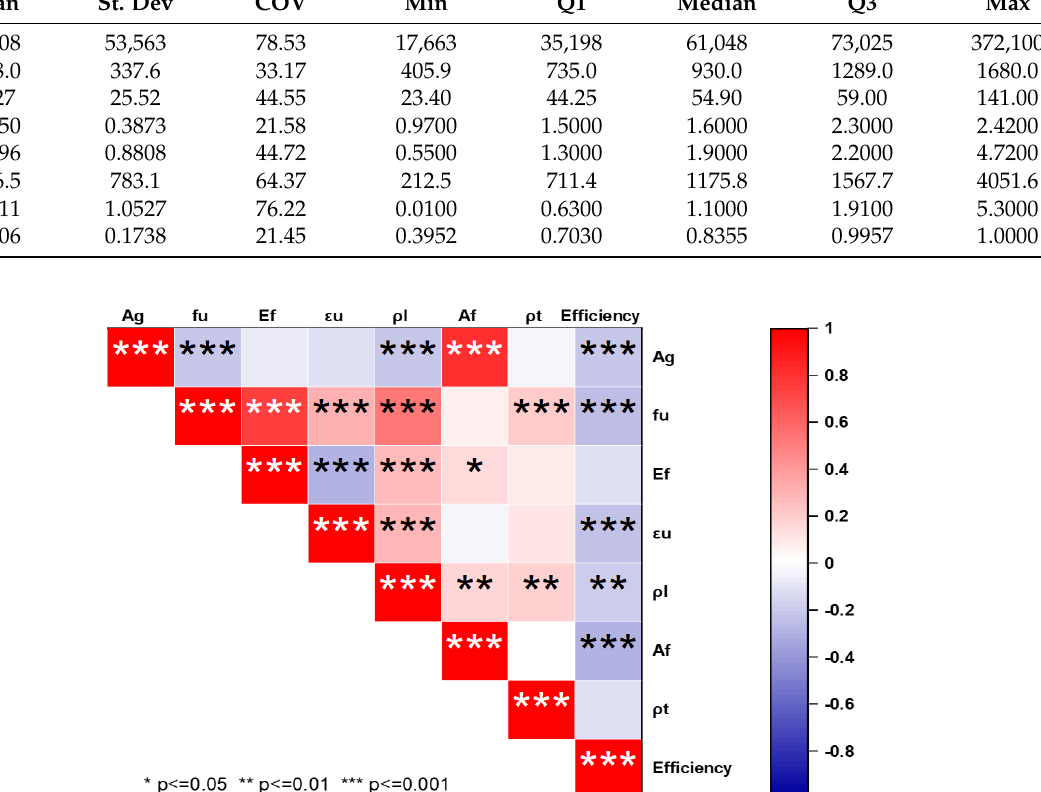
Figure 1. Significance level of the parameter used for GFRP - based reinforced concrete column.